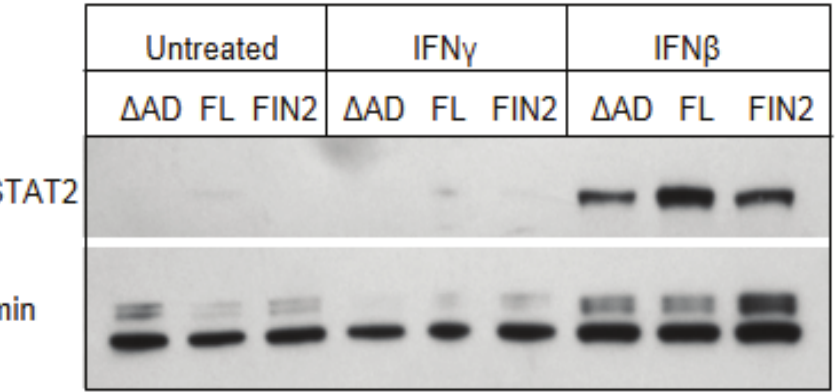
Figure 8. Phosphorylated STAT2 does not accumulate in the nucleus of IFN γ -treated MRC-5 cells. Film images of electrophoretically separated nuclear lysates reacted with antibodies to p-STAT2 and Lamin (loading control). MRC5 cells were nucleofected with full length IE1 (FL), the Δ 345–491 C-terminal truncation IE1 ( Δ AD) or empty vector (FIN2). At 72 hours after nucleofection, cells were exposed to IFN γ or IFN β for 30 minutes or left untreated. Cells were harvested and nuclear and cytoplasmic fractions were separated. Equal amounts of protein from the nuclear lysates were subjected to electrophoresis in a denaturing polyacrylamide gel. Proteins were transferred to nitrocellulose sheets and reacted with the indicated